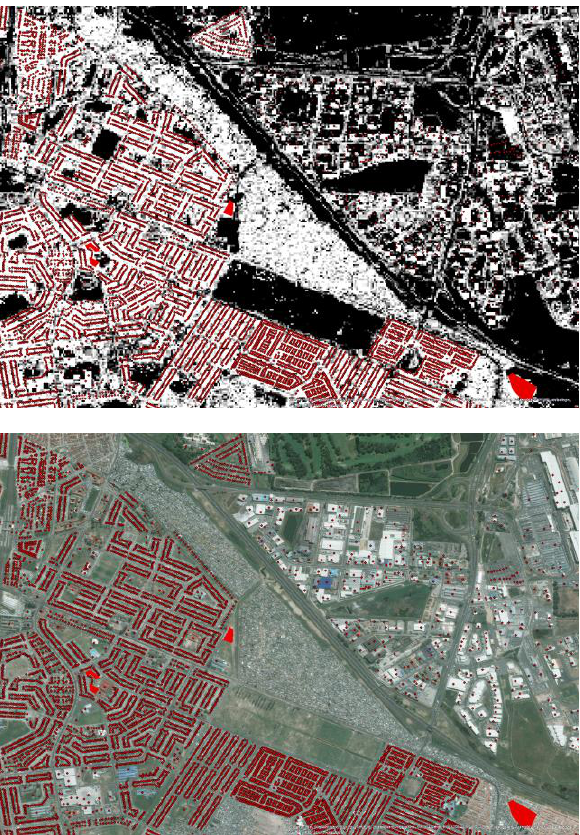
Figure 4. Cape Town. Comparison of SBC points (red dots and polygons) with built-up mask (top) and reference image (bottom).